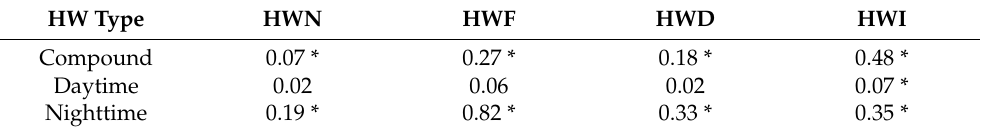
Table 1. Linear trends of wet compound, daytime and nighttime HWs in HWN (events decade − 1